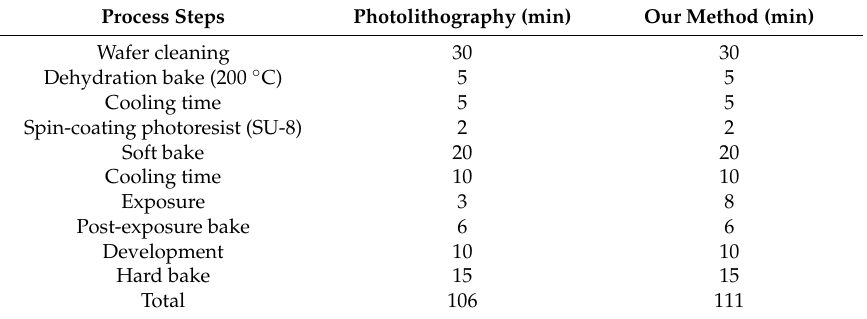
Table 2. The estimated time of fabricating the master.